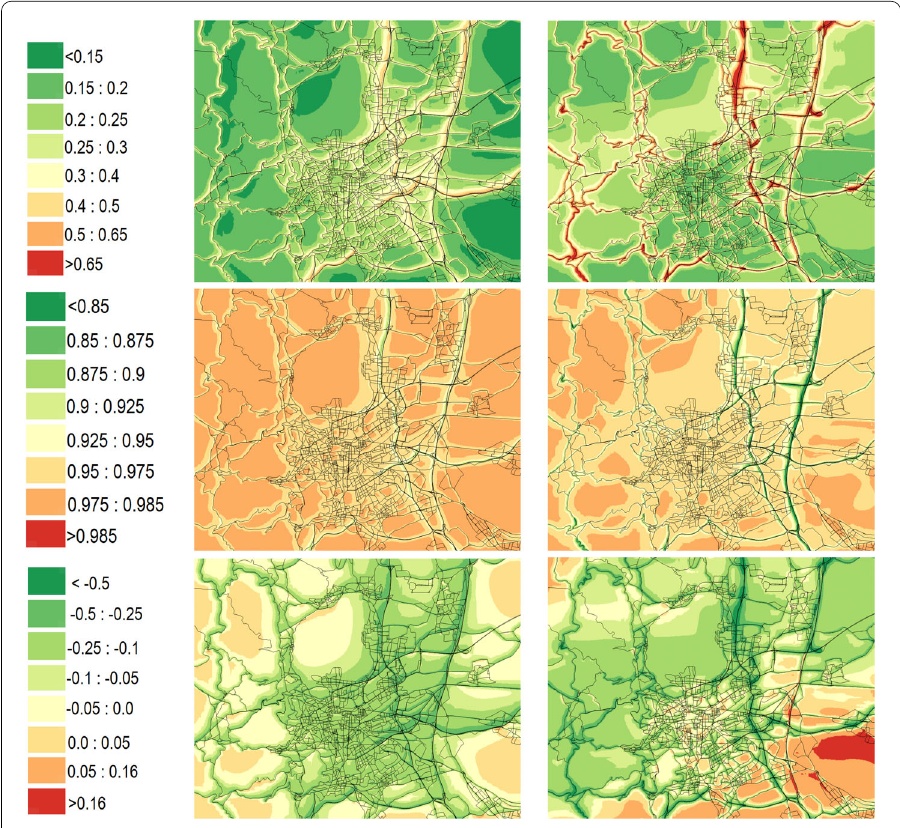
Fig. 8 Top: NRMSE (10) of the emulated NO 2 concentration field compared to the projected solution (left) and compared to the Sirane solution (right), for parameters over the month of November 2014. Center: correlation (12) over the same set. Bottom: normalized bias (13) over the same